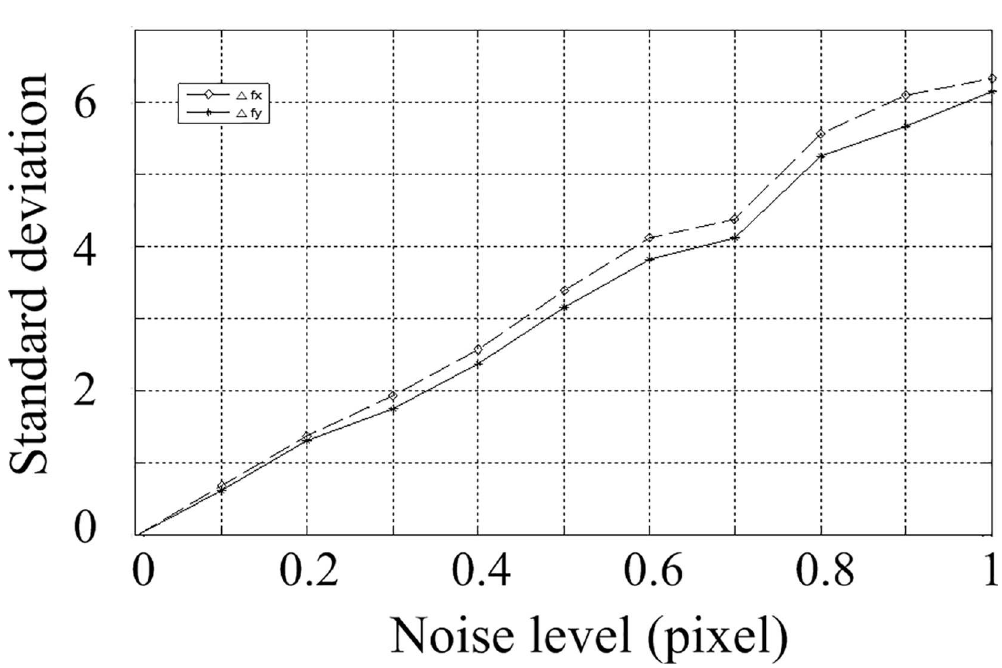
Fig 6. Standard deviations for parameters f x, f